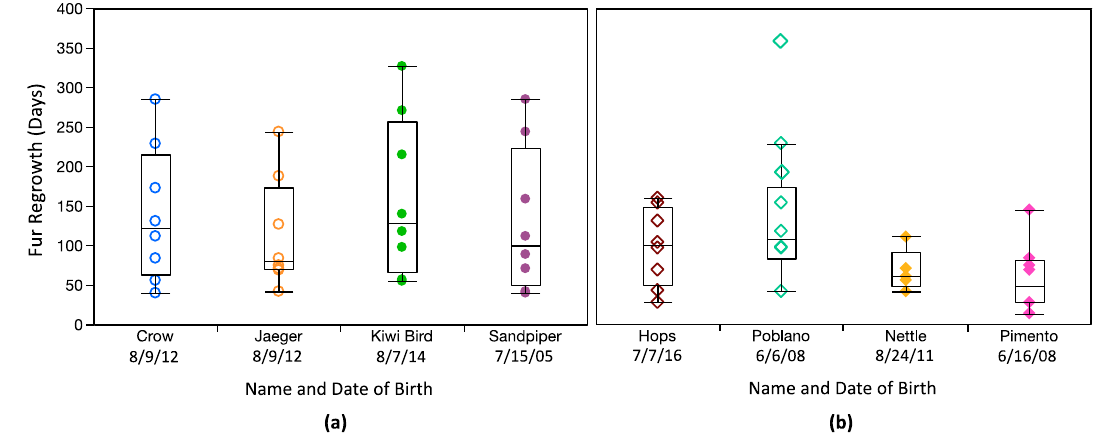
Figure 3. Box plots showing fur regrowth times for each ( a ) dwarf lemur, and ( b ) mouse lemur. There are no di ff erences in regrowth rate among individuals in either species ( p > 0.05). Boxes represent 25 and 75% quartiles, and whiskers contain 1.5 times the interquartile range. Measurements for Poblano’s RS3 (hip / thigh) and LS4 (base of tail) are shown but excluded from box plots and statistical comparisons. Symbology corresponds with Figures 1 and 2. Males are open symbols; females are closed symbols. Table 3. Summary regrowth rates for each shave and each species. Dates are presented as Month / Day / Year. More detailed information is provided in Supplementary Table S4.